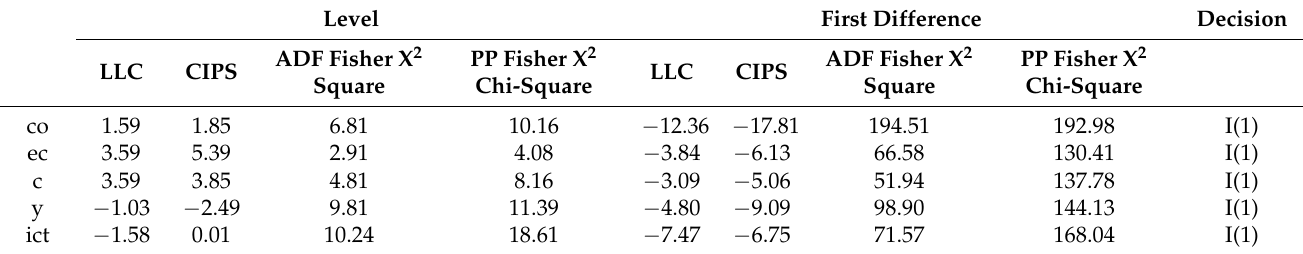
Table 5. LLC and CIPS Results.